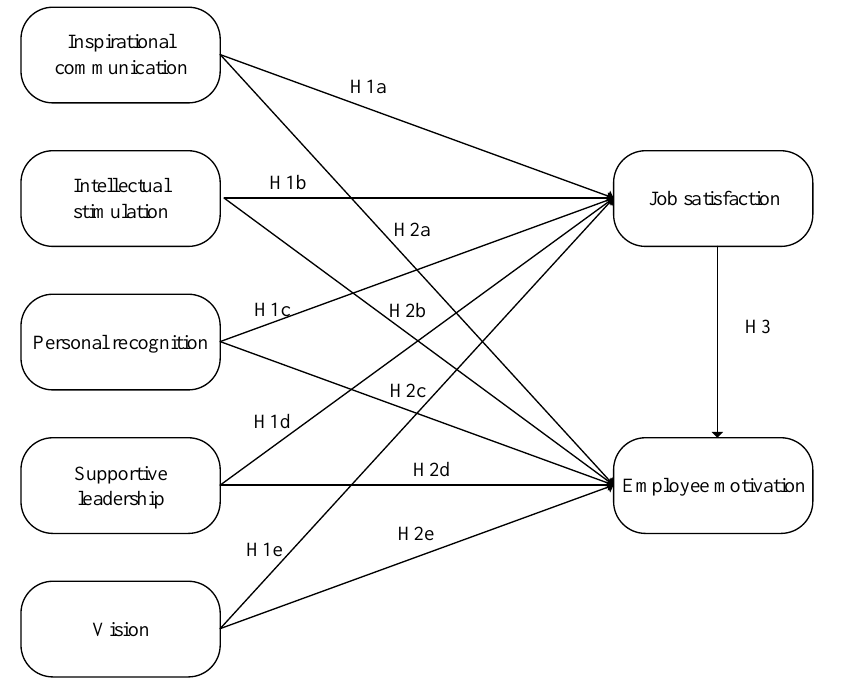
Figure 1. Proposed research model.